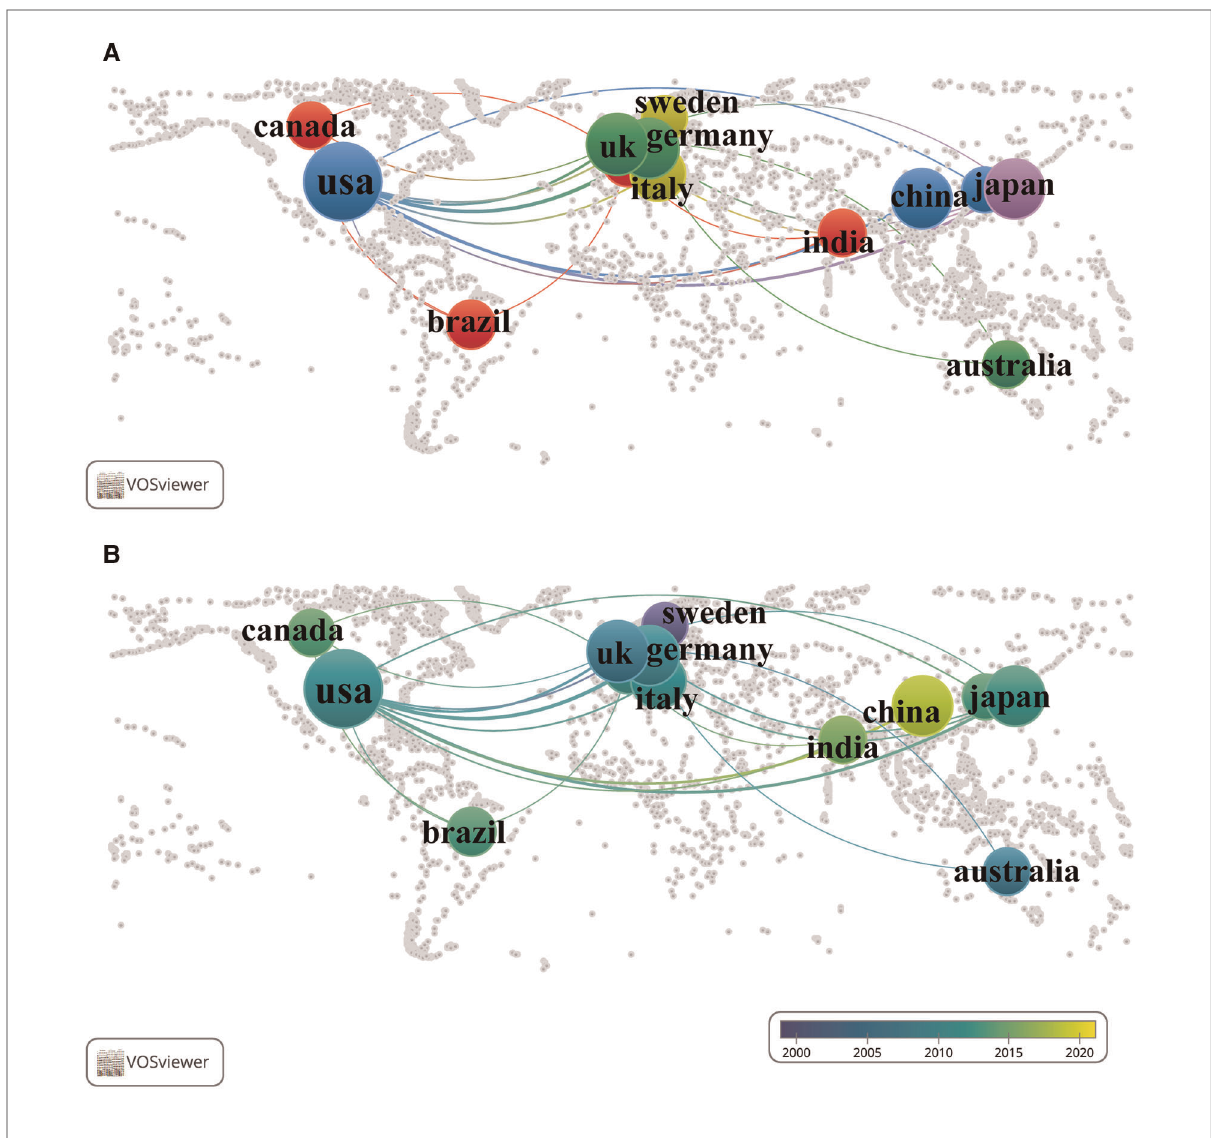
FIGURE 4 International collaboration networks among different countries/regions. Each node represents a country/region, and each line represents a link between two countries/regions. The size of each node represents the number of documents, and the thickness of each line represents the strength of the link. ( A ) The collaboration of 13 countries/regions with at least nine published documents on the world map. The colour of each node represents the clusters of each country/region. ( B ) The time-overlay collaboration map of 13 countries/regions with at least nine published documents on the world map. The colour of each node represents the average publication year, according to the colour gradient presented in the lower right